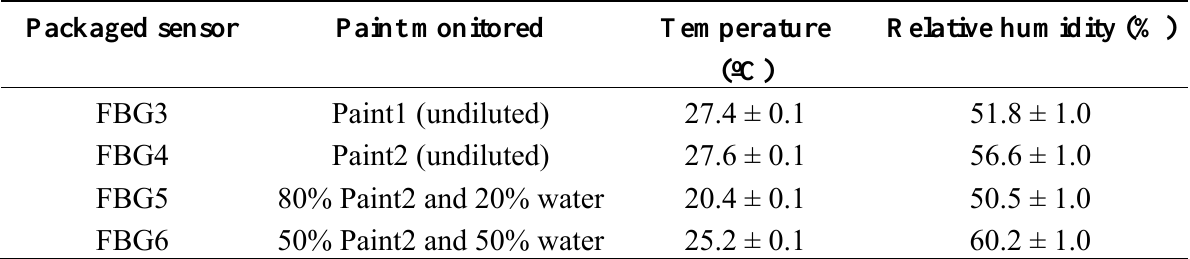
Table 2. Temperature and relative humidity during the experiments of paint drying process.